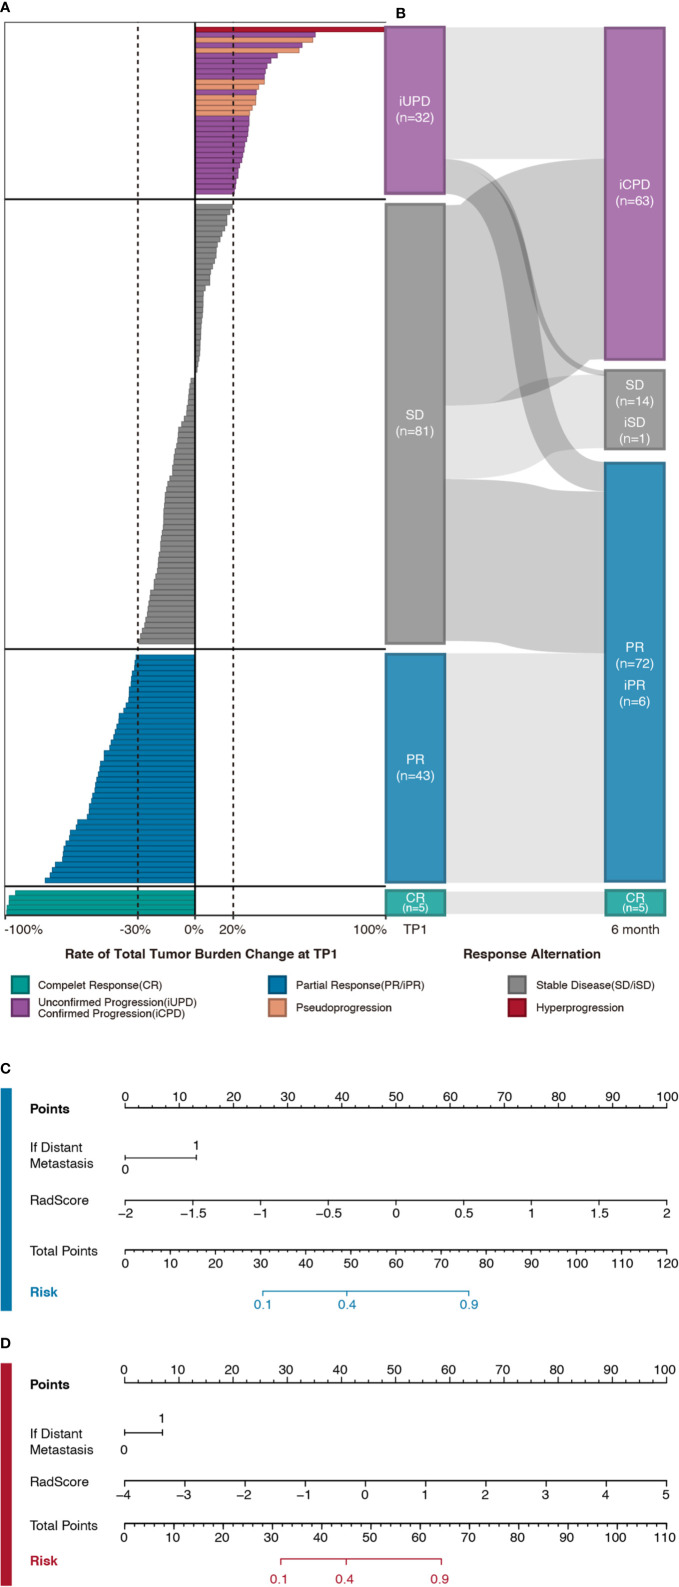

(A) Individual response map of patients in Delta-radiomics sub-cohort. Bars indicate the changes of total tumor burden between baseline and TP1 CT scans. Patients are grouped on the basis of therapy response at TP1 following iRECIST criteria (Complete response [CR] in green, partial response [PR] in blue, stable disease [SD] in gray, and unconfirmed progression [iUPD] in purple). In addition, hyper-progression (n = 1, in red) and pseudo-progression (n = 8, in orange) are noted as well. (B) Sankey diagram depicts therapy response alternation flow within follow-up interval. For those patients who met the progression threshold (20% increasement of tumor burden) at any time point within follow-up interval, updated response labels are attached according to their subsequent assessment (Confirmed progression [iCPD], stable disease [iSD], and partial response [iPR]). It’s noteworthy that for those patients who were thought to be iUPD at 6-month, their labels were determined by additional follow-ups so that any unconfirmed progression would not be used as labels in model training. (C, D) Nomograms of largest target lesion model (in blue) and target lesions model (in red) which were developed in training set respectively.